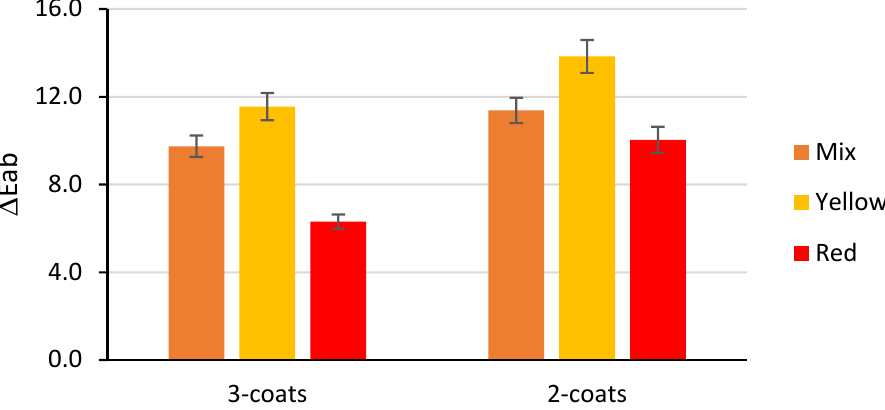
Figure 7. Discoloration of thermally modified wood exposed outdoors for 220 days depending on the iron oxide pigments used in the coating formulation.